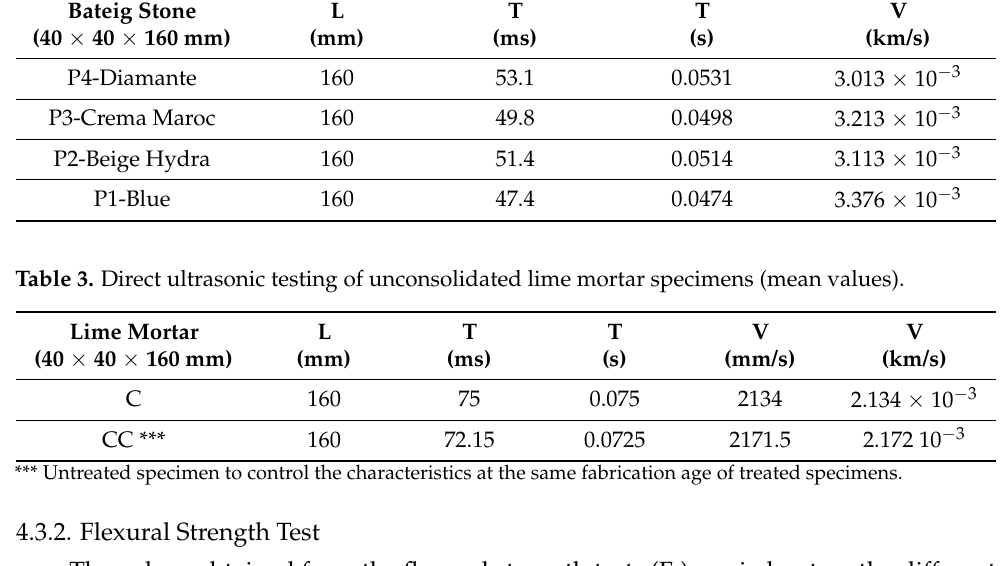
Table 2. Direct ultrasonic testing of unconsolidated Bateig stone specimens (mean values). Bateig Stone